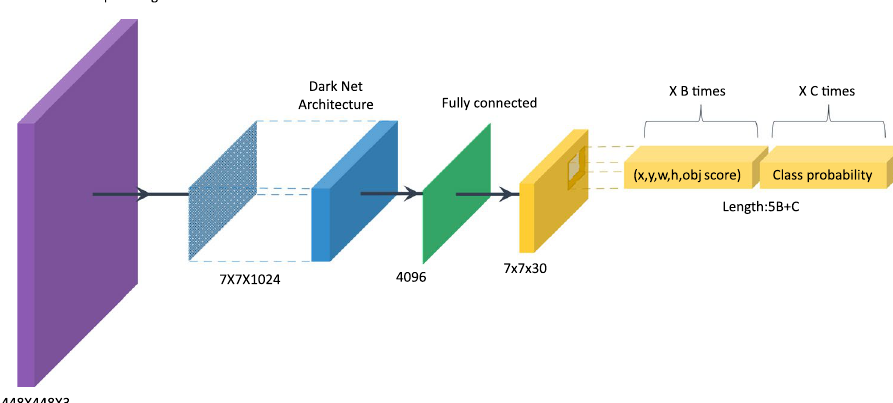
Figure 1. Structure of the YOLO